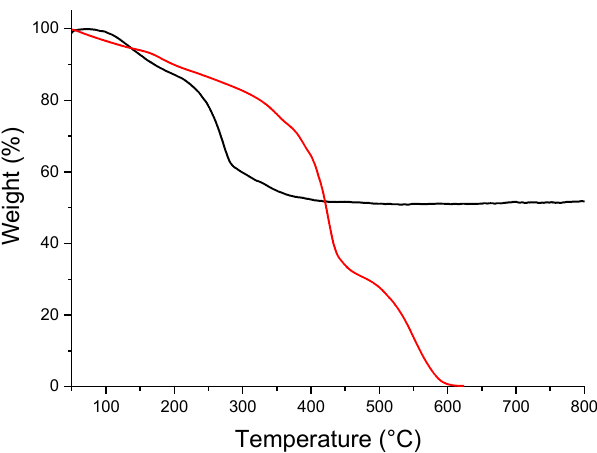
Figure 5. Thermogravimetric analysis (TGA) thermogram of AgNP@P(PEG350) 3 (black line) and P(PEG350) 3 (red line), in air atmosphere.